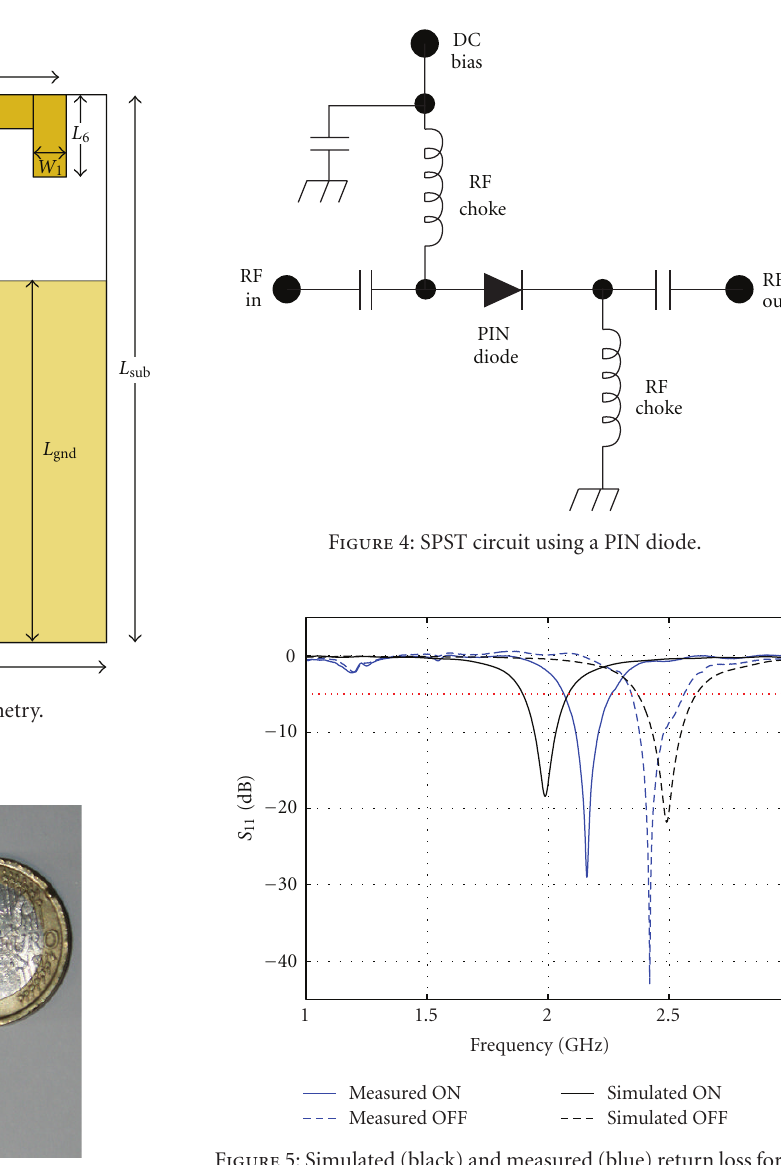
Figure 5: Simulated (black) and measured (blue) return loss for the PIN diode in “ON” (solid) and “OFF” (dashed)